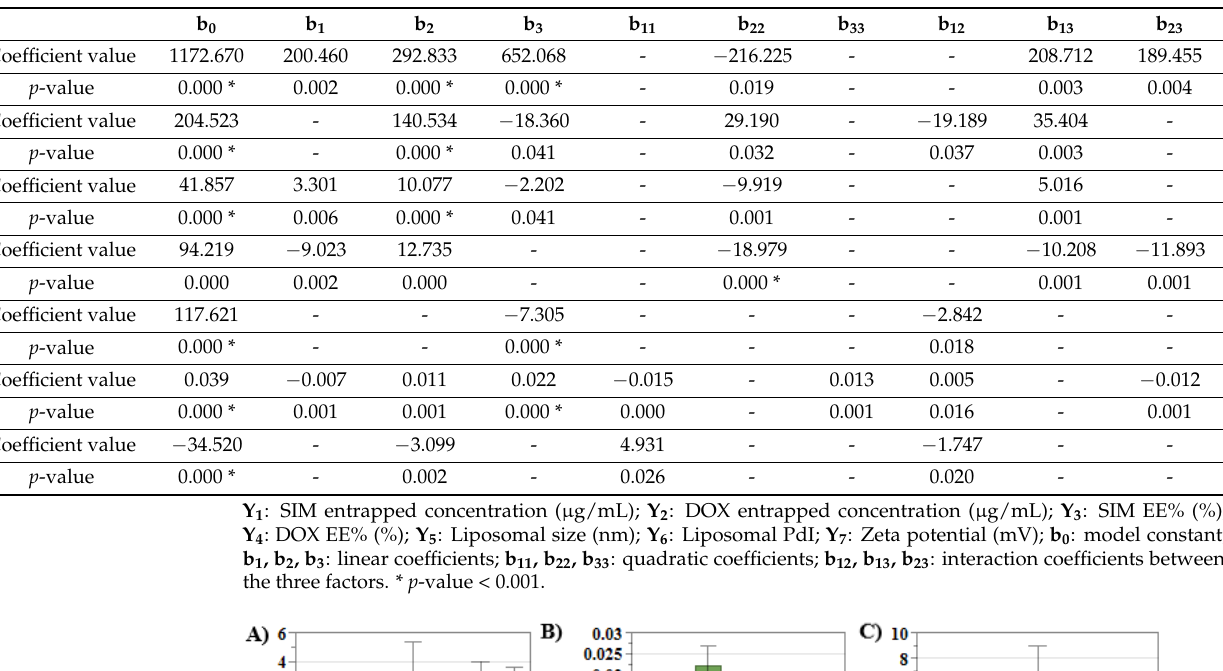
Table 3. The regression coefficients.